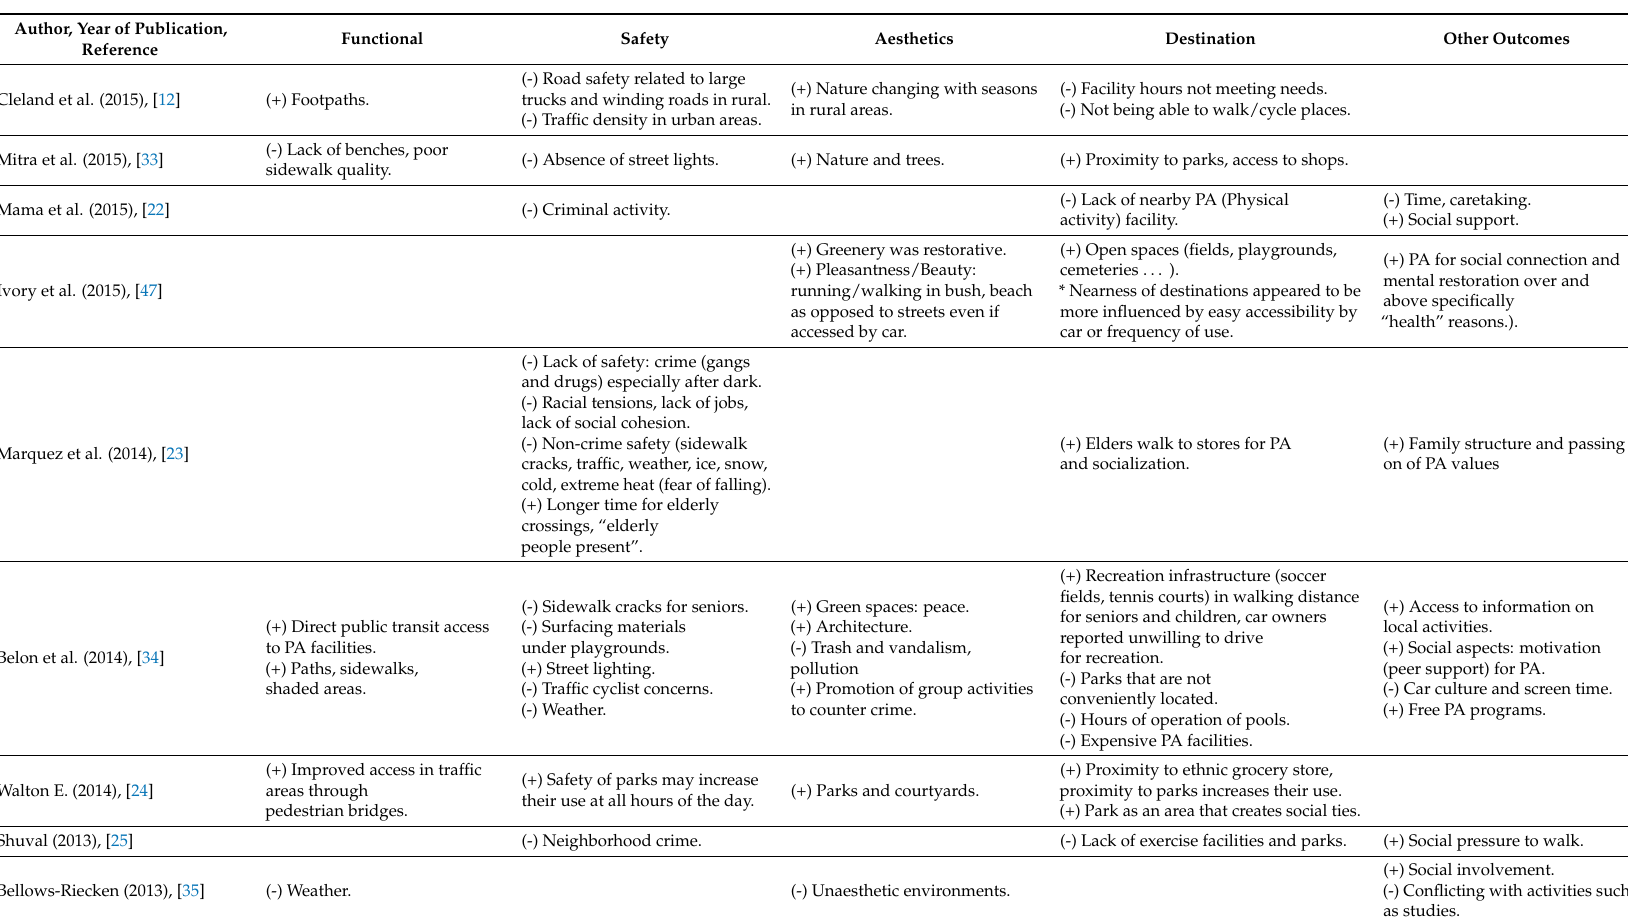
Table A2. Summary of findings related specifically to the BE features and PA extracted from the reviewed studies ( n =